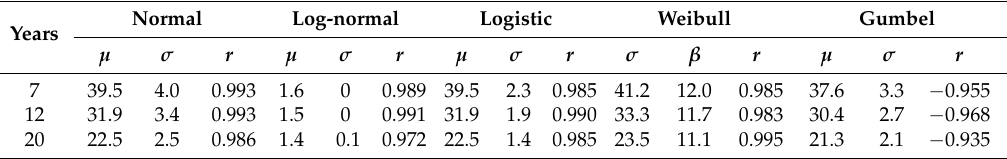
Table 3. Distribution parameters and correlation coefficients of the distribution models.